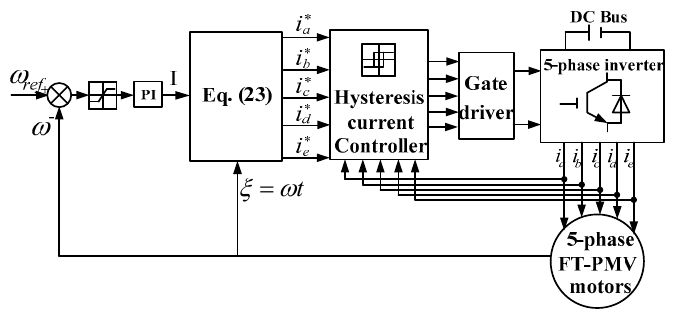
Figure 7. Experimental setup.